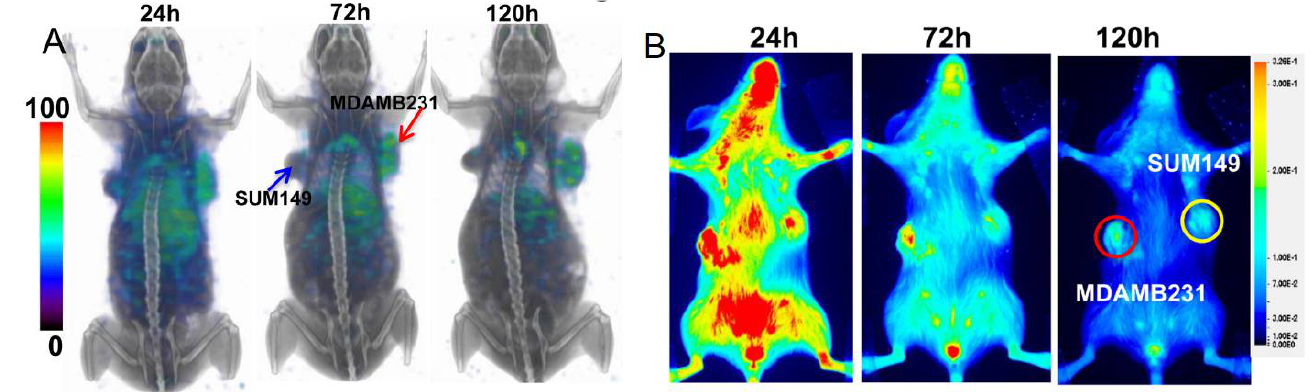
Figure 3. Imaging PD-L1 expression in orthotopic breast cancer xenografts with [ 111 In]In-atezolizumab and NIR-atezolizumab. ( A ) NSG mice with orthotopic MDAMB231 and SUM149 xenografts were administered intravenously with 14.8 MBq (400 µCi) of [ 111 In]In-atezolizumab or 22 µg of NIR-atez, and images were acquired at 24, 72, and 120 h after the injection of the mAbs. 3D volume-rendered whole-body SPECT/CT images demonstrate the specific accumulation of activity in the MDAMB231 tumors. ( B ) Optical images acquired in the 800 nm NIR channel show the specific accumulation of the fluorescence signal in the MDAMB231 tumors. Adapted with permission from [34].